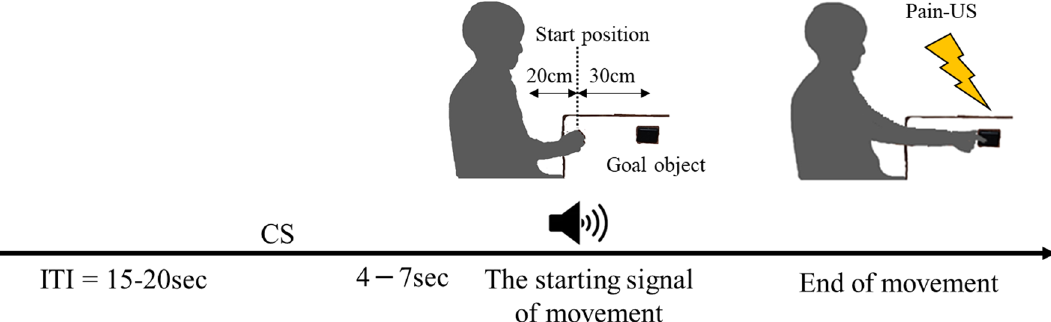
Figure 1. Flow chart of the experimental task. CS: conditioned stimulus. Lightning bolt: The presentation of the painful electrocutaneous stimulus (pain-US).